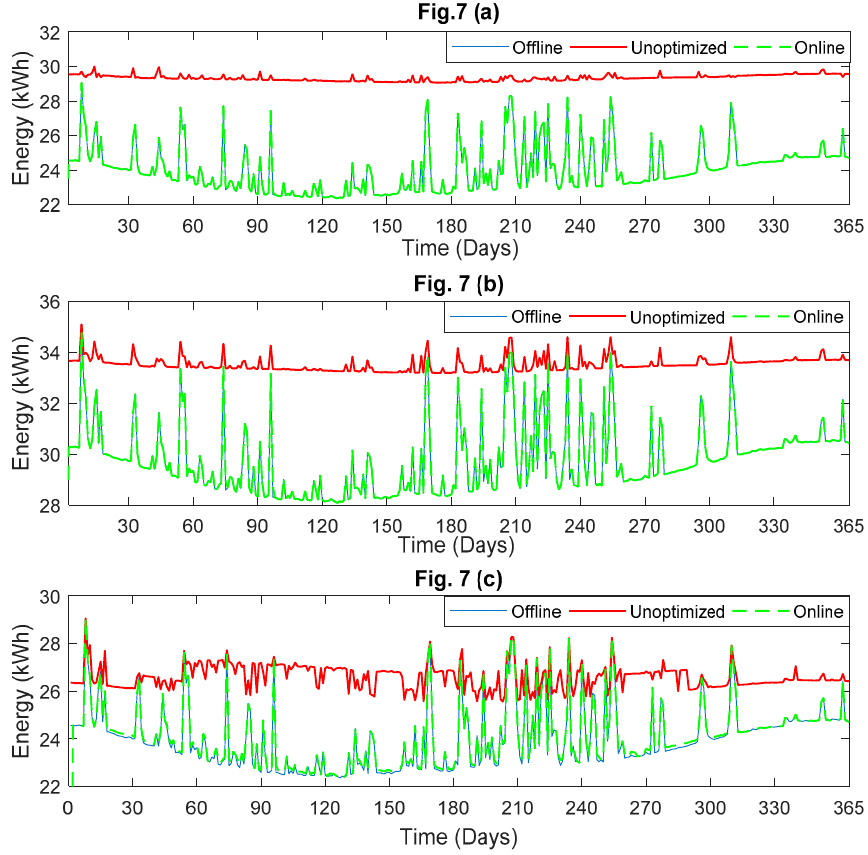
Figure 7. Daily energy demand from the grid throughout the year for the base case and optimized scenarios. ( a ) for 4-h load shedding (grid unavailable); ( b ) for 8-h load shedding (grid unavailable); ( c ) for 12-h load shedding (grid unavailable).